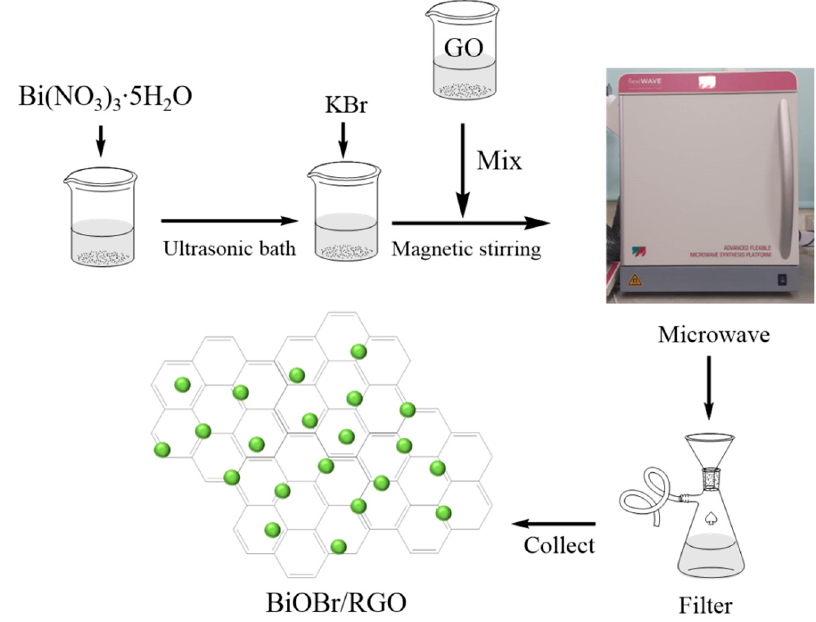
Figure 1. Schematic illustration of the synthesis process of the BiOBr-G nanomaterial.